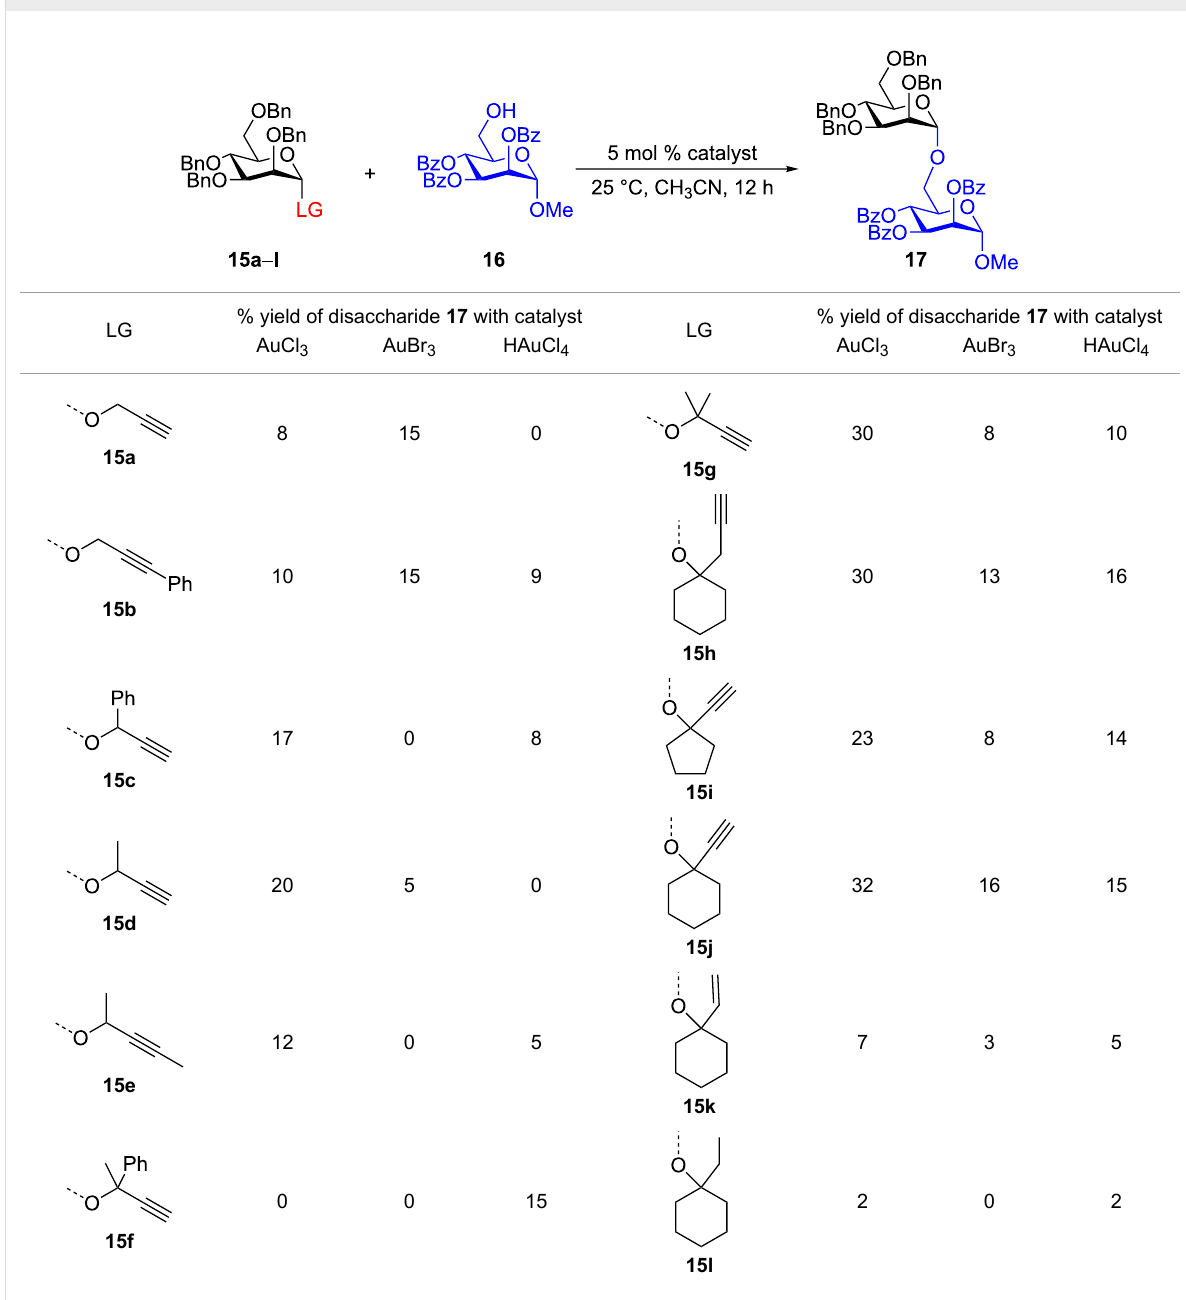
Table 1: Room temperature